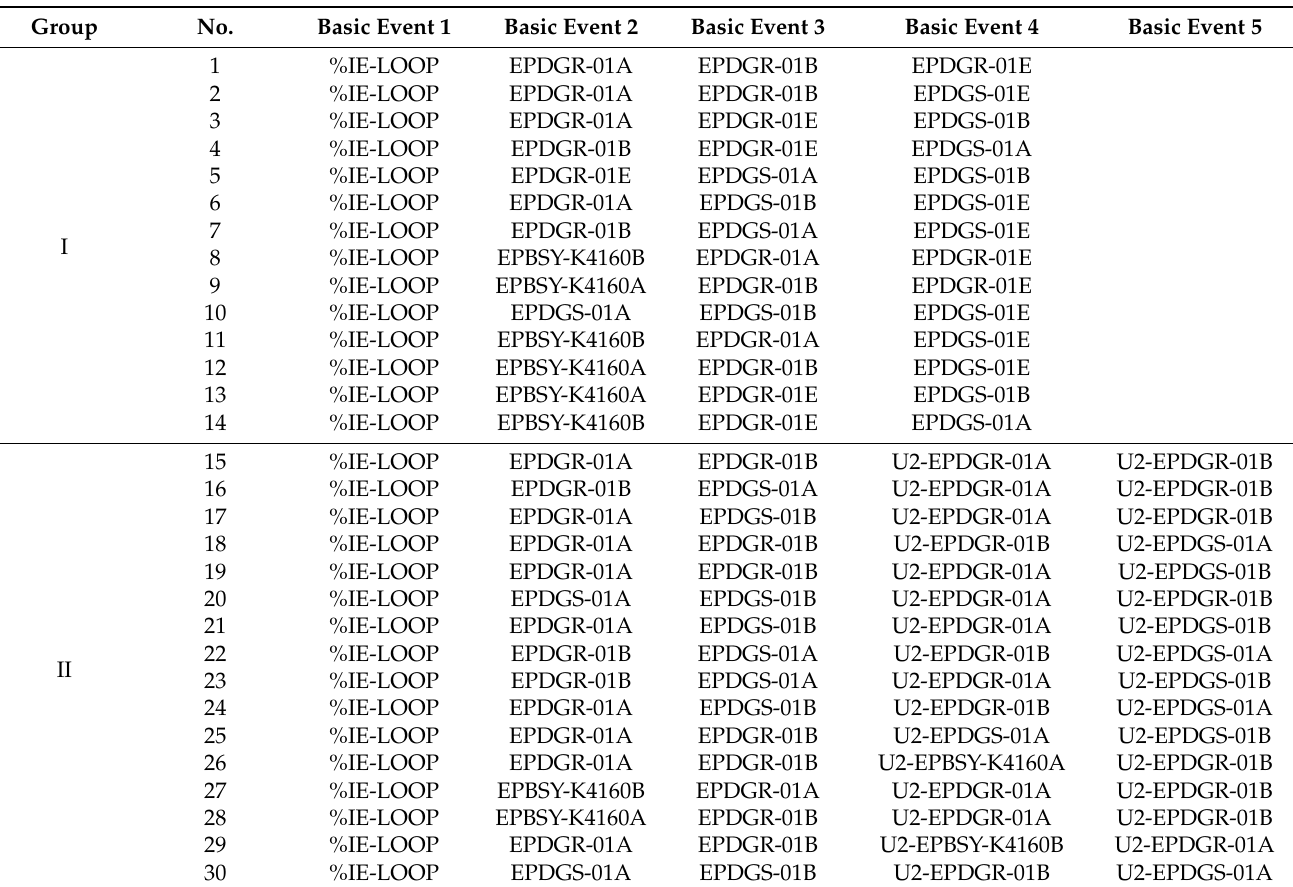
Table 8. The top 30 cutsets presented by AIMS-PSA software as the result of the